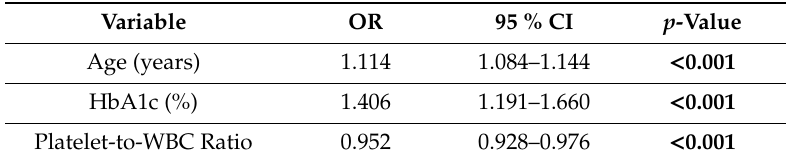
Table 7. Reliable multivariate logistic regression analysis for the parameters most strongly associated (Wald p < 0.001) with POD after CABG. POD, Postoperative delirium; CABG, coronary artery bypass grafting.